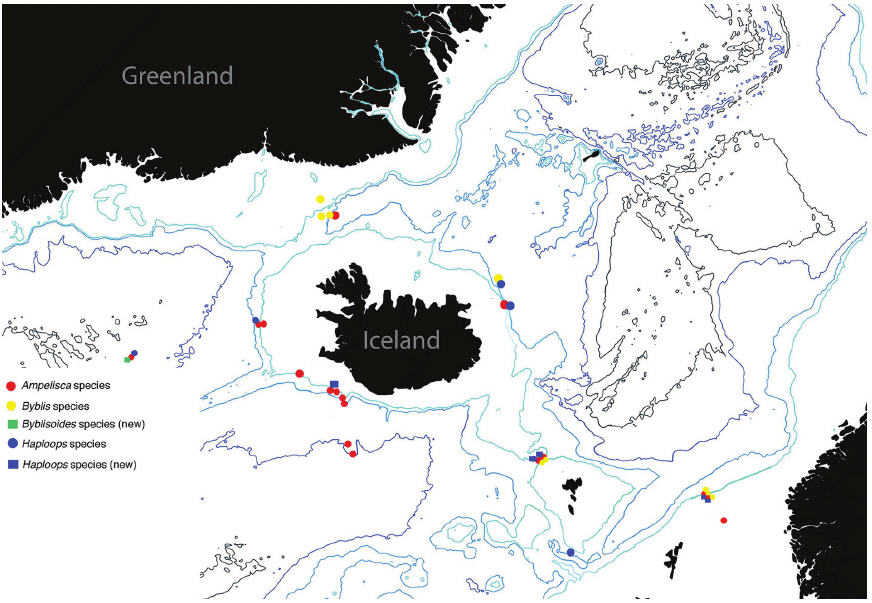
Figure 1. Map to the distribution of species from Icelandic waters in the genera of Ampeliscidae, high- lighting the new species